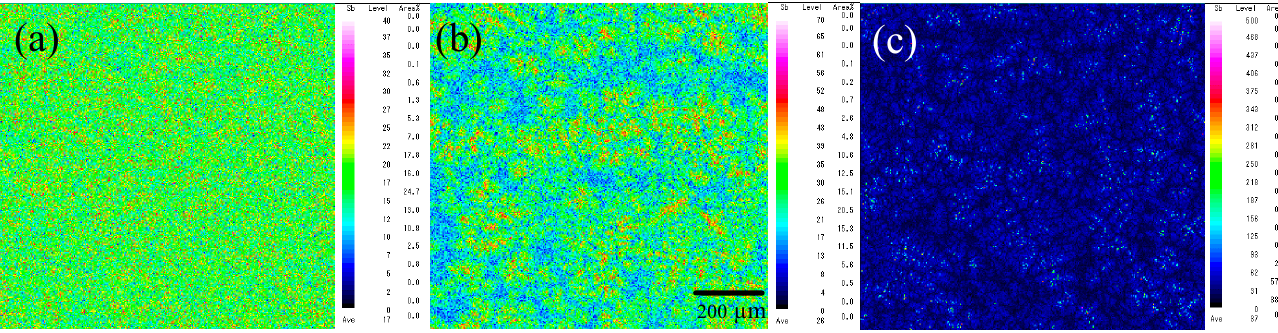
Figure 3. EPMA mapping images of Sb in ( a ) Sn-40Bi-0.1Sb, ( b ) Sn-40Bi-0.5Sb, and ( c ) Sn-40Bi-1.0Sb.